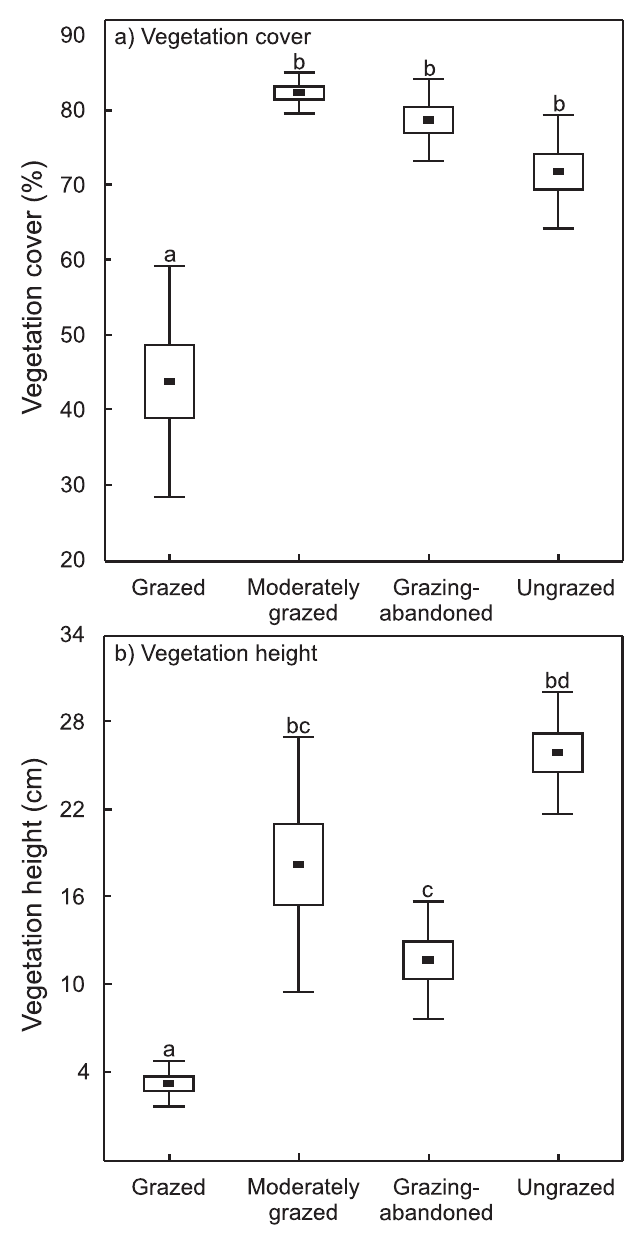
Fig. 6. Mean values (min-max and ±SE) of vegetation cover and veg- etation height on the studied sites. Significant (p<0.05) differences detected by Mann-Whitney U test are indicated by different